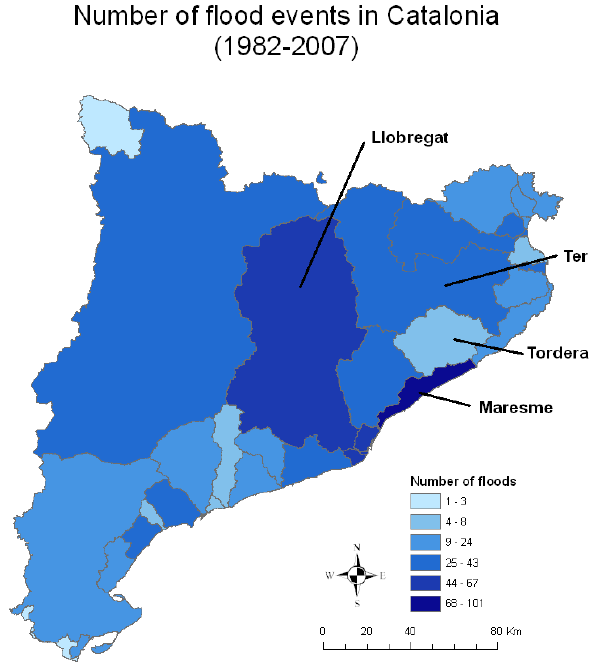
Fig. 2. Distribution of flood events by river basins, recorded in Cat- alonia between 1982 and 2007. The basins cited in the text are showed. Figure 2. Distribution of flood events by river basins, recorded in Catalonia between 1982 and 2007. The basins cited in the text are showed.